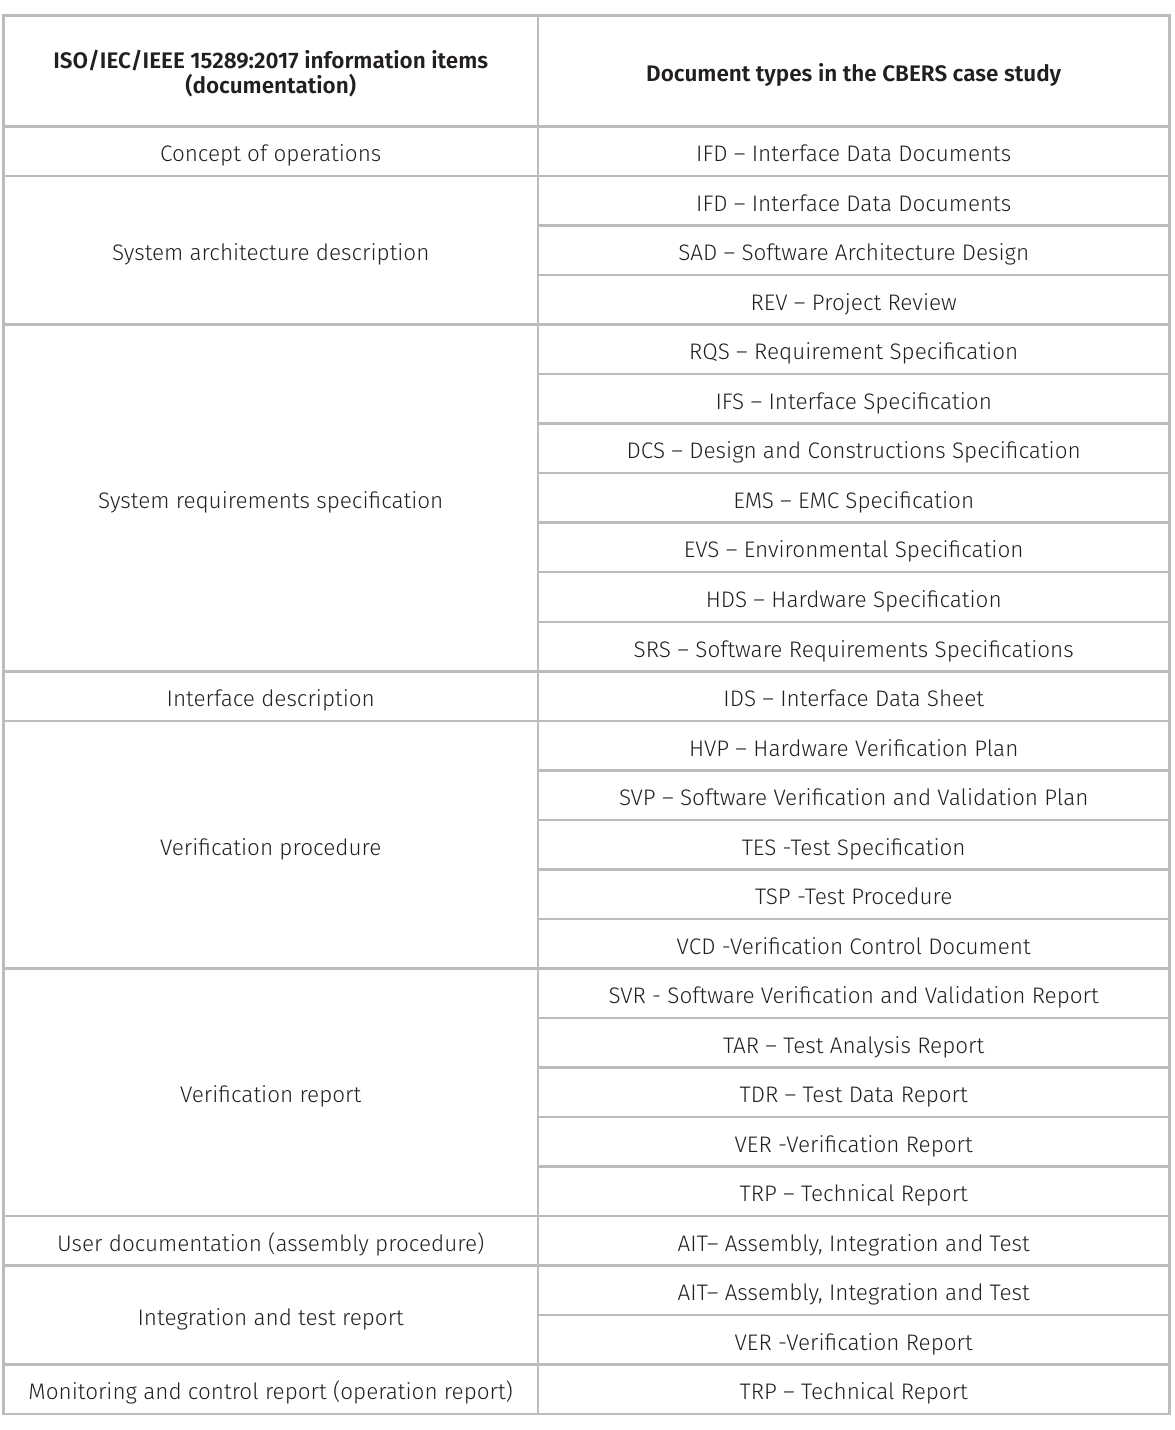
Table V. Document types found in the case study. ISO/IEC/IEEE 15289:2017 information items